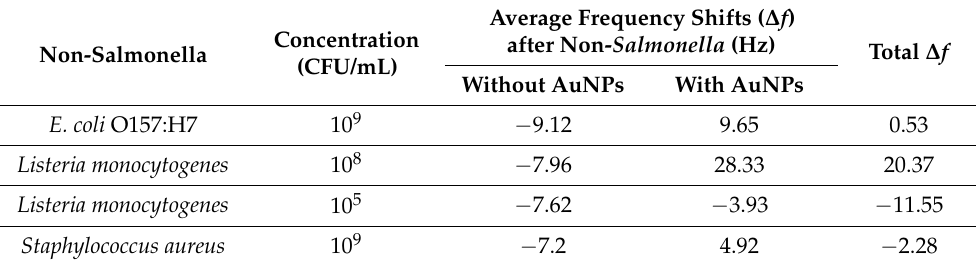
Table 2. Results of specificity tests. After non- Salmonella , negative frequency shifts were shown. After AuNPs, positive frequency shifts were observed. The results indicated that they might be washed off after the washing steps.